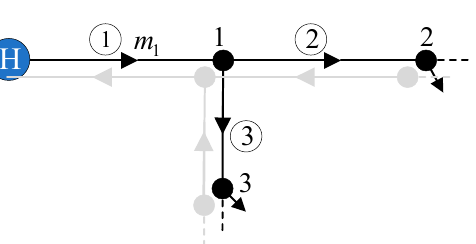
Figure 1. Probabilistic mass flow model of a radial district heating network consisting of a heat source node H, three pipes, and three nodes. Here, the circled values represent pipes and the arrows represent the direction of mass flow rates.